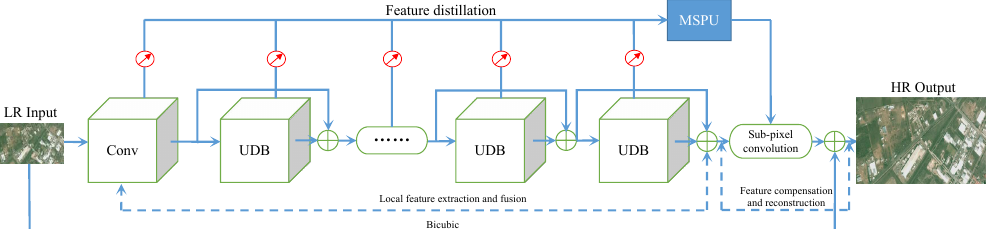
Figure 2. Outline of the proposed deep distillation recursive network (DDRN). The red distillation symbol followed the UDB represents the distillation operation with a special distilled ratio of α